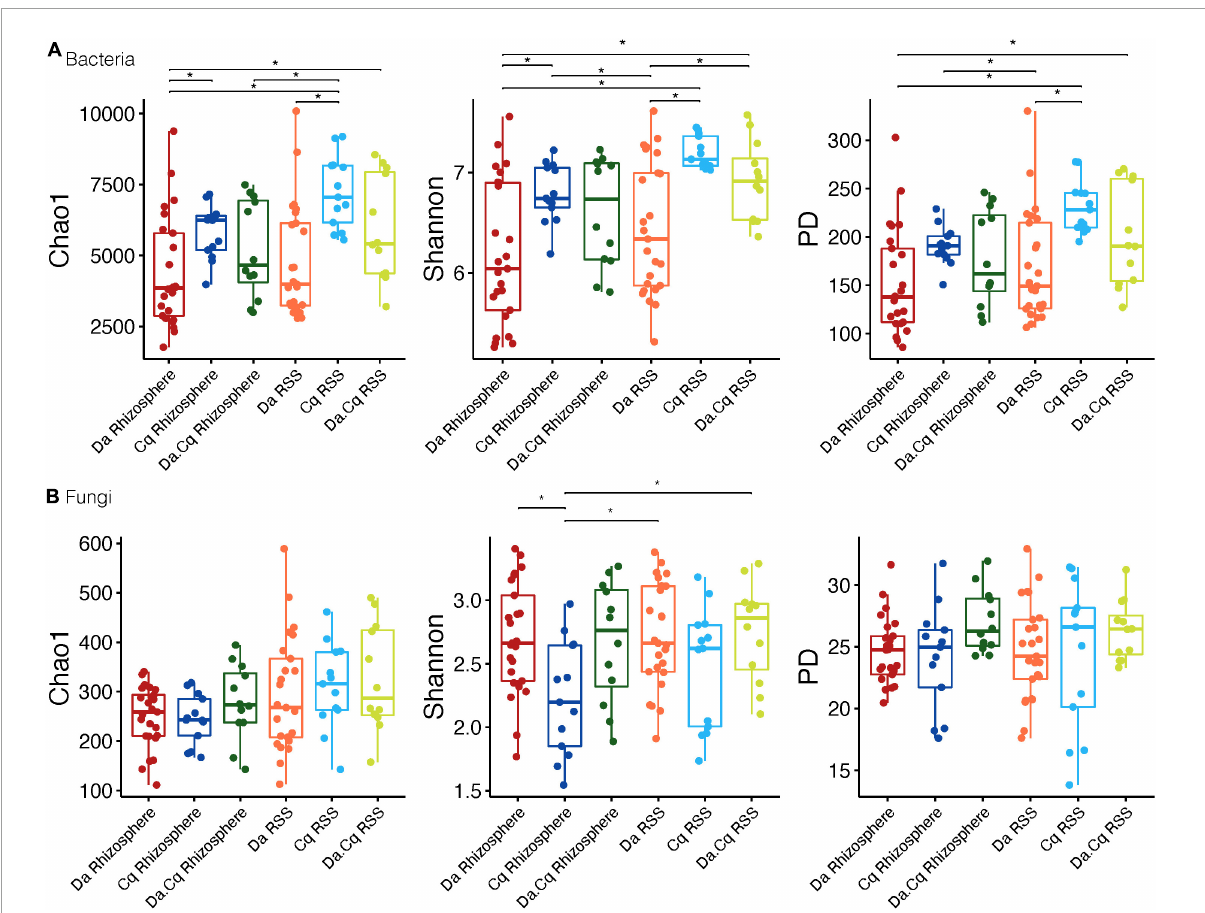
FIGURE2 Bacteria (A) and fungi (B) alpha diversity (Chao1; Shannon; phylogenetic diversity) for plant species and their compartments (rhizosphere, rhizosphere-surrounding soil [RSS]) Deschampsia antarctica [Da], Colobanthus quitensis [Cq], and their association [Da.Cq]. Dots represent data points, and boxplots represent the interquartile range of alpha diversity. Statistically significant differences (Tukey’s HSD p -value ≤ 0.05, for predicted alpha diversity by a linear model) are marked by